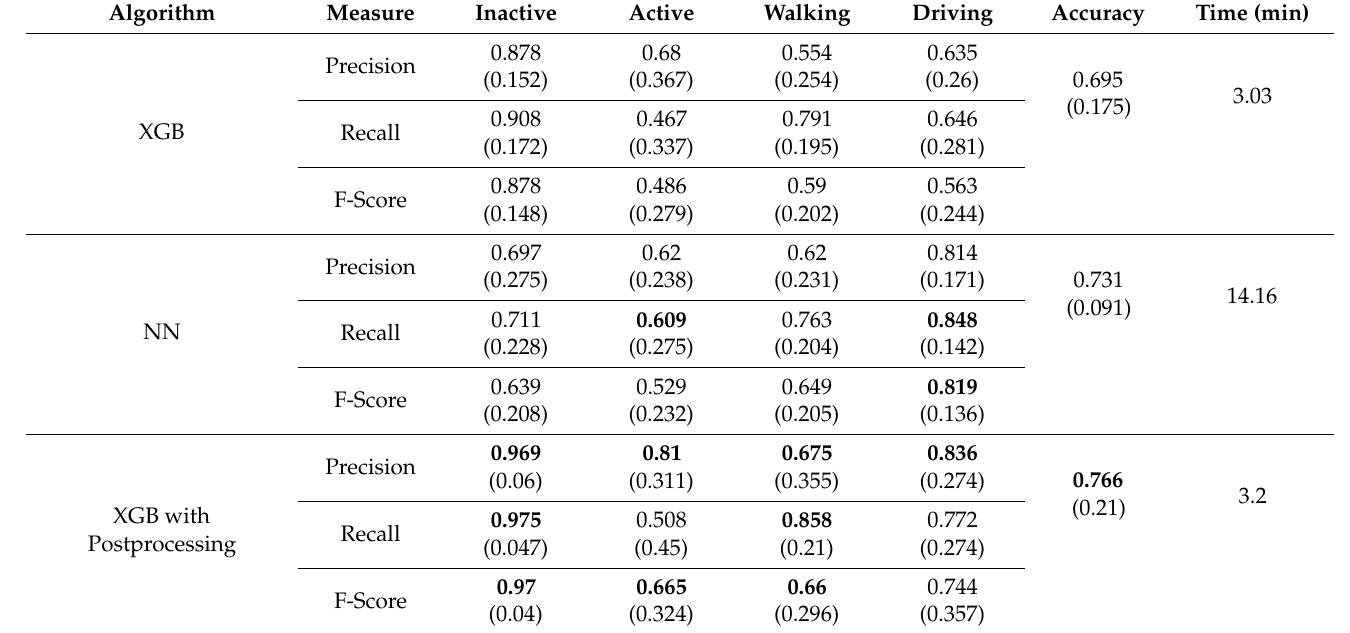
Table 9. Results for user-wise stratified